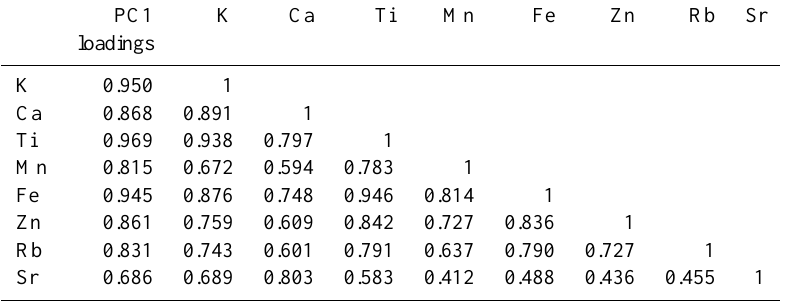
Table 2. XRF PC1 factor loadings and correlation matrix for scanning XRF elemental data. PC1 K Ca Ti Mn Fe Zn Rb Sr loadings K 0.950 Ca 0.868 Ti 0.969 Mn